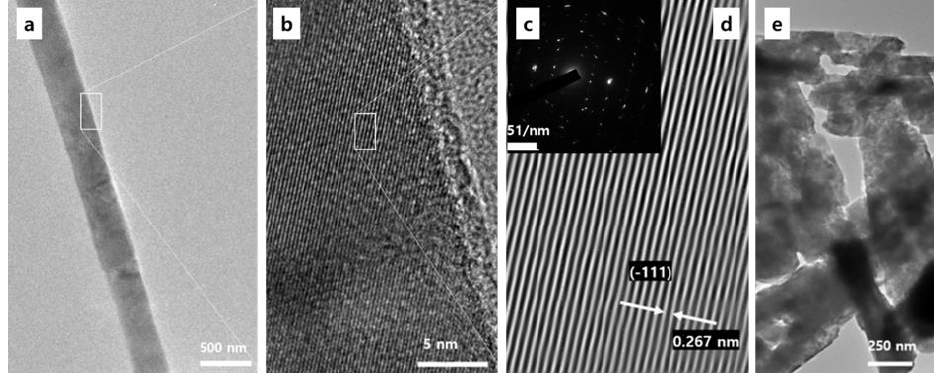
Figure 3. ( a , b ) TEM image of the high-aspect ratio β -Ga 2 O 3 nanorods obtained from the hydrothermal